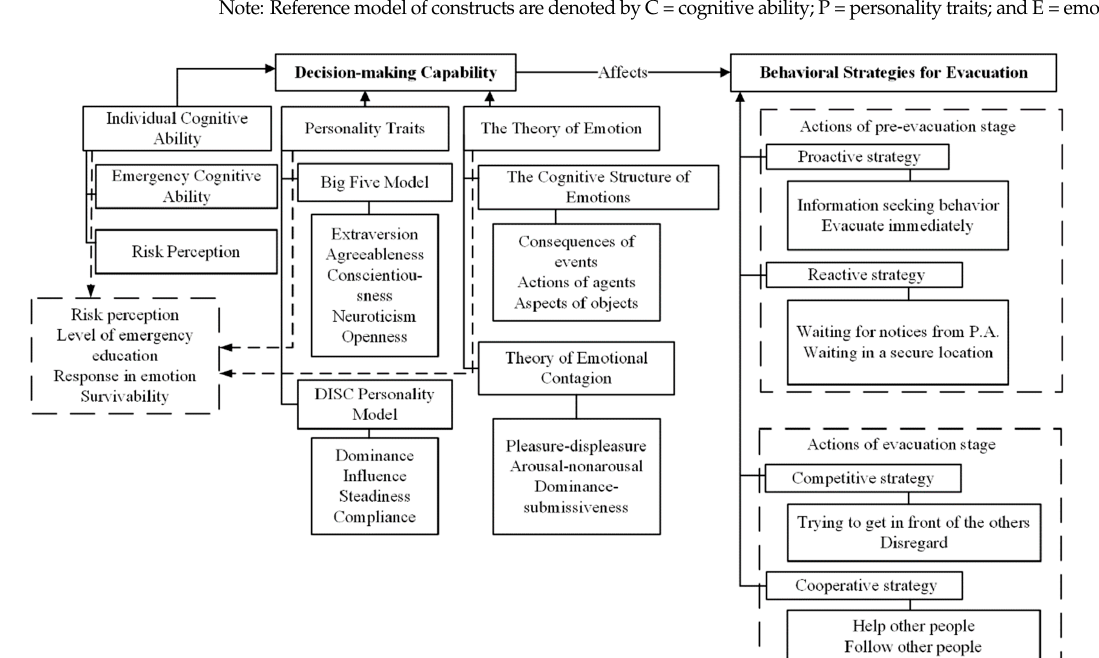
Figure 2. Hypothetical structural model.